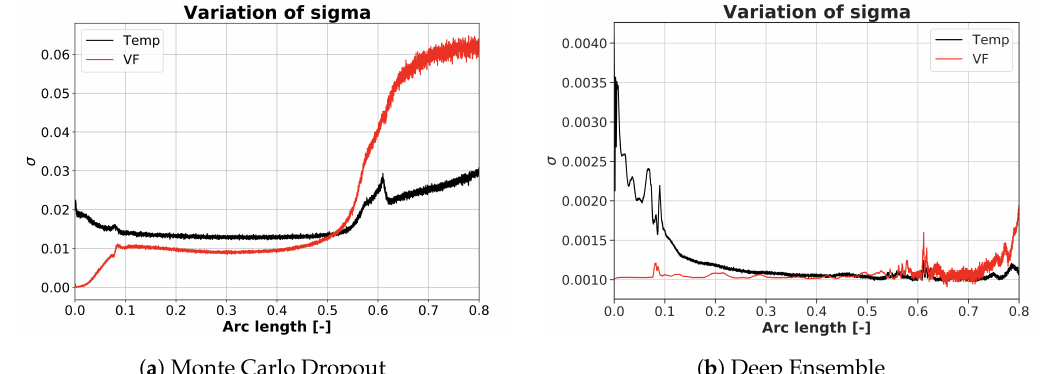
Figure A9. Interpolation dataset: q (cid:48)(cid:48) = 14,000 W/m 2 , u =0.05 ms − 1 . In the Figure the standard deviation of the wall temperature and void fraction along the arc length for both the models. When comparing the σ variation between MC Dropout and DE models, it is clear that the σ variation of DE is smaller by approximately one order of magnitude. The correlation and sensitivity that exist between the wall temperature and void fraction is shown. From the plot is evident that slight change in σ for the void fraction influences the σ of wall temperature. There is a sharp increase in σ for the void fraction in MC dropout model and this is due to transition of regime from saturated boiling to film boiling.